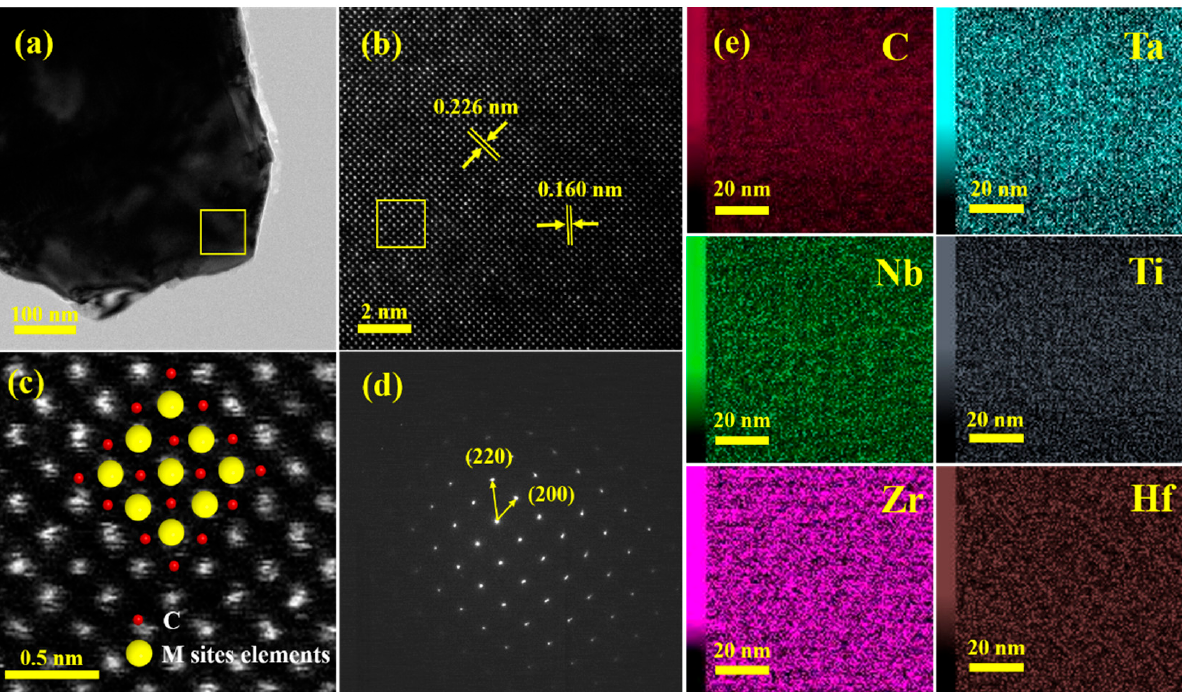
Figure 4d. Figure 4e is the energy dispersive spectrometry (EDS) map of the yellow border in Figure 4a. The six elements Zr, Hf, Ti, Nb, Ta, and C are uniformly distributed in the material without evident segregation, which further verifies the successful preparation of high-entropy (Ta 0.2 Nb 0.2 Ti 0.2 Zr 0.2 Hf 0.2 )C.